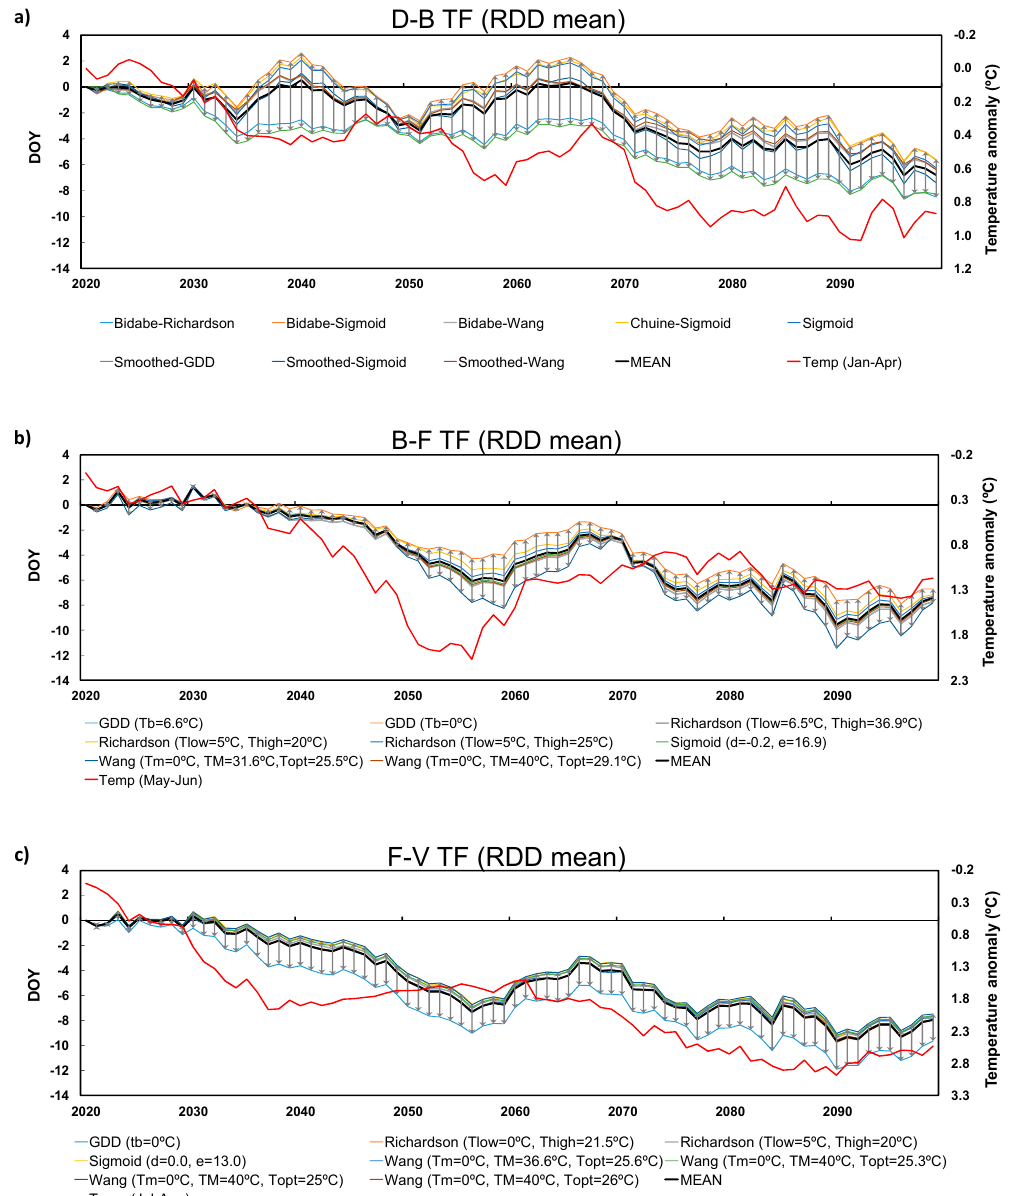
Figure 3. Chronograms (2020–2100, RCP4.5) of the phenological timings (days of the year, DOY) of ( a ) Dormancy–Budburst (D-B); ( b ) Budburst–Flowering (B-F) and ( c ) Flowering–Veraison (F-V), and for cv. Touriga Franca (TF), obtained from the eight selected models (cf. legends), averaged for all climate models and the 12 sites in the Douro Demarcated Region (DDR) (Figure 1). The average maximum–minimum ranges for each phenophase (among the di ff erent phenology models) are also pointed out (values in days within boxes in the right-upper corner of each panel). The red curves correspond to the ( a